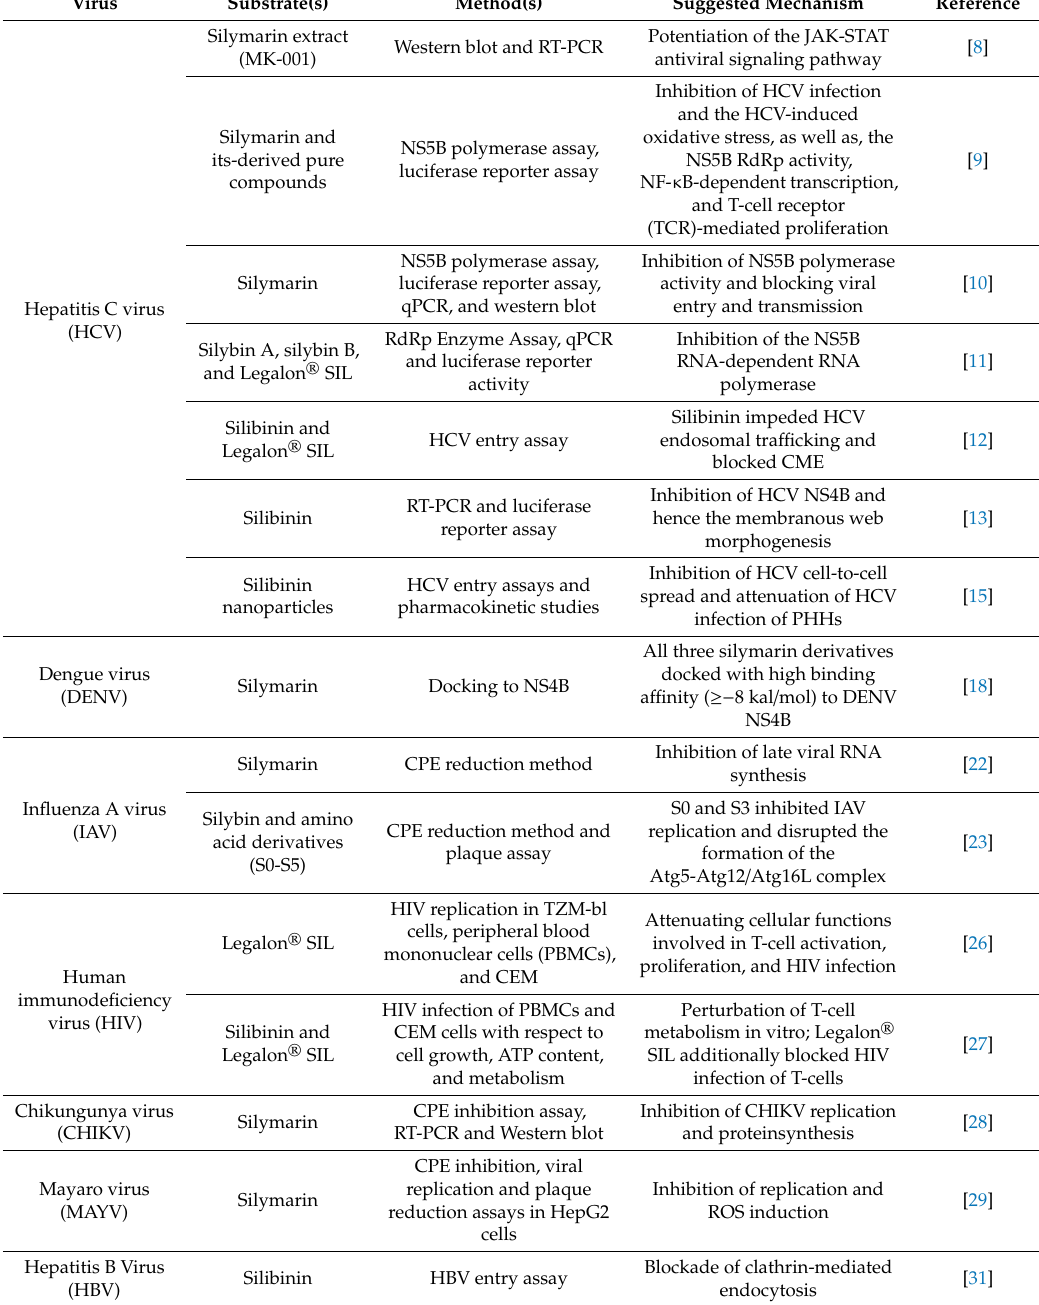
Table 1. Preclinical studies of silymarin and derivatives in vitro and in